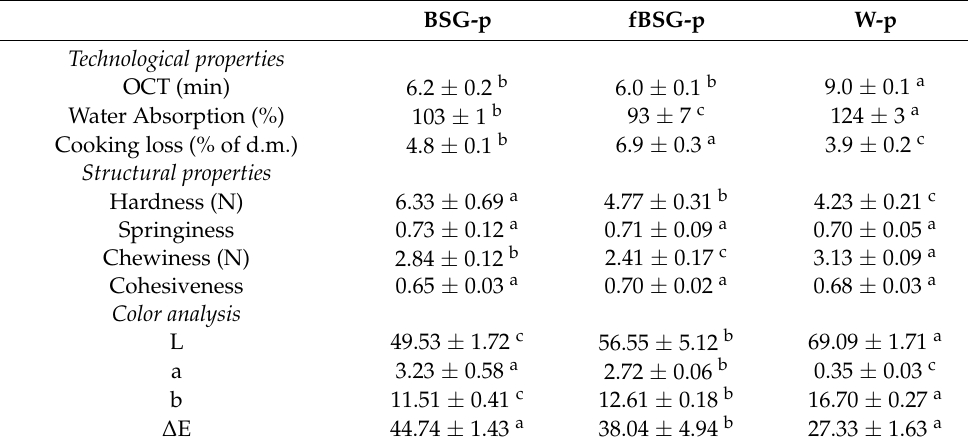
Table 3. Technological and structural properties and color indexes of pasta containing fermented and native brewers’ spent grain: BSG-p, pasta containing native brewers’ spent grain (15% wt/wt in replacement of semolina); fBSG-p, pasta containing fermented brewers’ spent grain (15% wt/wt in replacement of semolina); W-p, pasta made with durum wheat semolina. BSG-p fBSG-p W-p Technological properties OCT (min) 6.2 ± 0.2